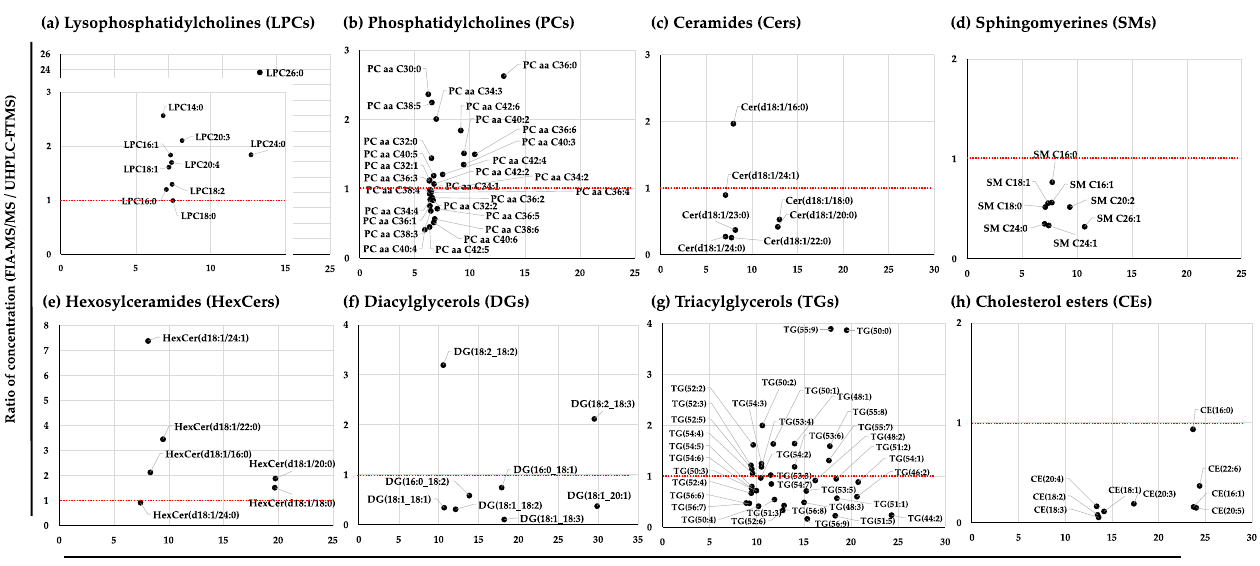
Figure 5. Correlation plots of lipid species in the NIST plasma samples detected by UHPLC-FTMS and Kit-Met 2. ( a ) Lysophosphatidylcholines (LPCs); ( b ) phosphatidylcholines (PCs); ( c ) ceramides (Cers); ( d ) sphingomyelins (SMs); ( e ) hexosylceramides (HexCers); ( f ) diacylglycerols (DGs); ( g ) triacylglycerols (TGs); and ( h ) cholesterol esters (CEs). Metabolites were selected with a CV < 30% from 33 NIST plasma samples detected with Kit-Met 2. The correlation of concentrations was calculated by the ratio between the mean values of 33 NIST plasma samples detected by Kit-Met 2 and the mean values of 5 NIST plasma samples detected by UHPLC-FTMS. The red dotted line shows the 1.0 correlation of the ratio.